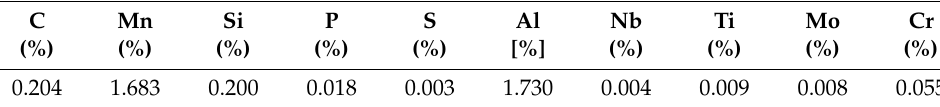
Table 1. The chemical composition of the RAK 40/70 Z100MBO